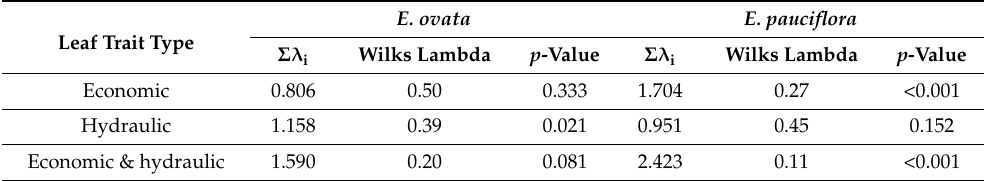
Table 3. Multivariate analysis of variance (MANOVA) for the primary leaf economic and hydraulic traits, showing the generalized variance ( Σ λ i ) as well as Wilks lambda and its statistical significance ( p -value). E. ovata E. pauciflora Leaf Trait Type Σ λ Σ λ i Wilks Lambda p -Value i Wilks Lambda p